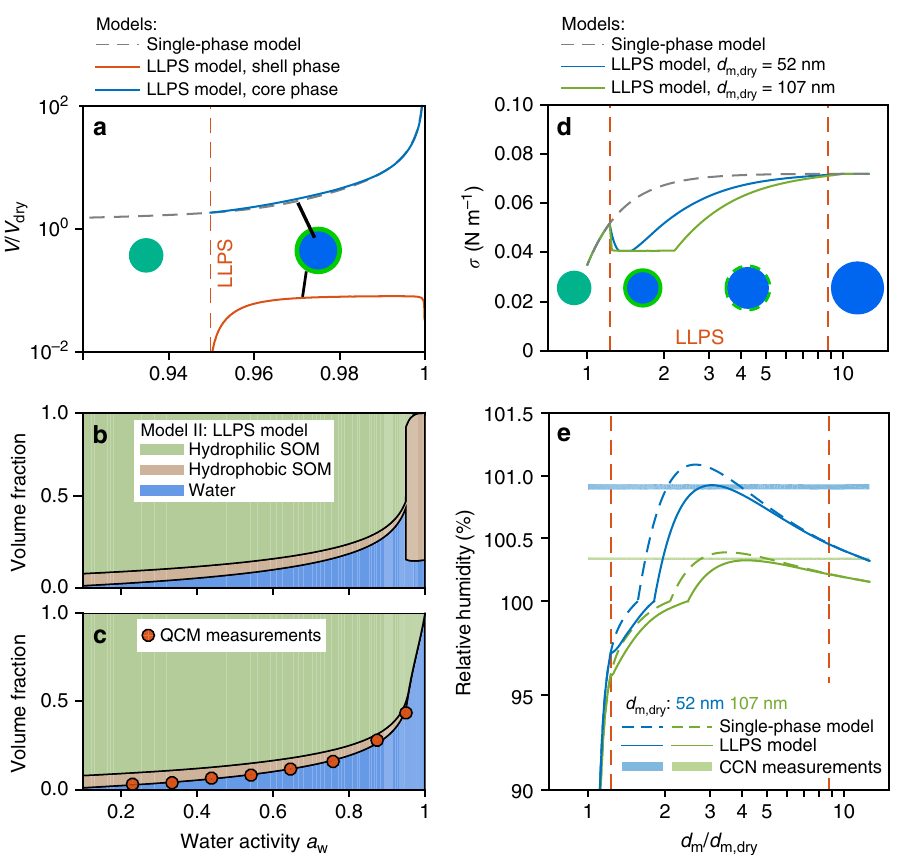
Fig. 3 Thermodynamic model predictions for an α -pinene-derived SOM particle. a Volume V of single and separated phases across a water activity range of 0.92 – 1. The dashed gray line shows the single-phase case predicted by Model I. Orange and blue lines show the shell and core phases, respectively, predicted by Model II when LLPS is present. Values are normalized by the volume V dry of organic material when dry. The red dashed vertical line marks the predicted onset conditions of LLPS. The V / V dry value of the shell phase drops off when water activity approaches unity because of the mixing of two phases into a single phase. Predicted volume fractions of hydrophilic, hydrophobic organic components, and water are shown in b for the surface and in c for the core of the particle. The discontinuity of hydrophobic SOM volume fraction shown in b represent onset of the LLPS. The volume fractions of water calculated based on the mass-based QCM measurements of hygroscopic growth are shown in c for comparison. d Predicted surface tension coef fi cient σ vs. the diameter growth factor d m / d m,dry . Predictions are made for dry diameters of 52 nm (blue) and 107 nm (green). Cartoons in a , d show the possible morphology of the particle. Blue and green colors represent water and organics, respectively. e Köhler curves of relative humidity vs. diameter growth factor predicted based on the surface tension shown in d . Measured supersaturations for 52 and 107 nm diameter particles are marked as horizontal lines for comparison. The thicknesses of the lines are scaled by the measurements'